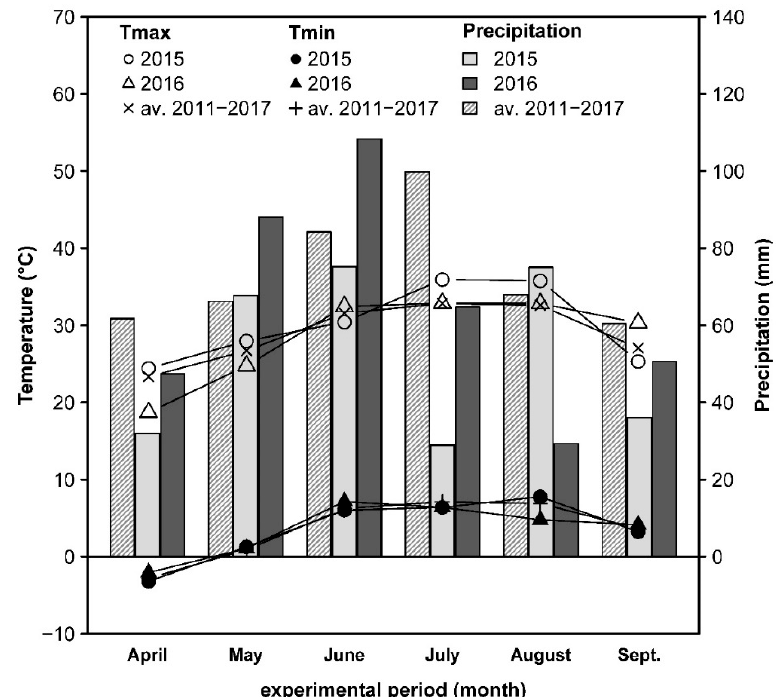
Figure 1. Total monthly precipitation, long-term average (av.) monthly precipitation, mean monthly maximum (T max ) and minimum temperature (T min ) and long-term av. monthly maximum and minimum temperature during the experimental period in 2015 and 2016.